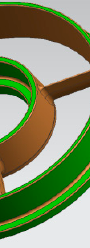
Figure 2. Gating system ( a ) integrated gating system, ( b ) bottom 4× runner, and ( c ) bottom 8× run- ner. In ( a ), the plan view, the case is in brown and the gating system is in green. ( b , c ) show the bottom view. In ( b ), the metal liquid flows from the 4× cross runner into the case. In ( c ), the metal liquid flows from the 4× cross runner into the case. Table 1. The main thermal and physical properties of TiAl alloy and ceramic shell mold for simula- tion [24–27]. Material